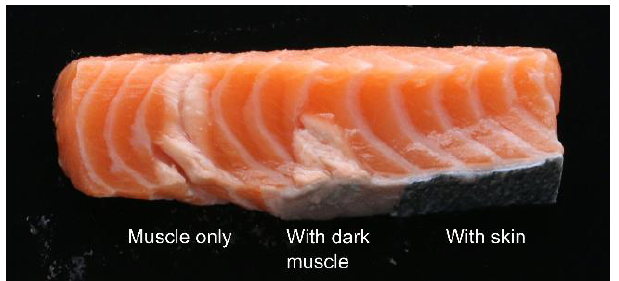
Figure 9. Salmon fillet treated with a 680 kHz transducer at a 55 mm distance for 20 s, in three different points (from left to right): Skinned, with skin removed but fat and dark muscle remaining, and with skin.